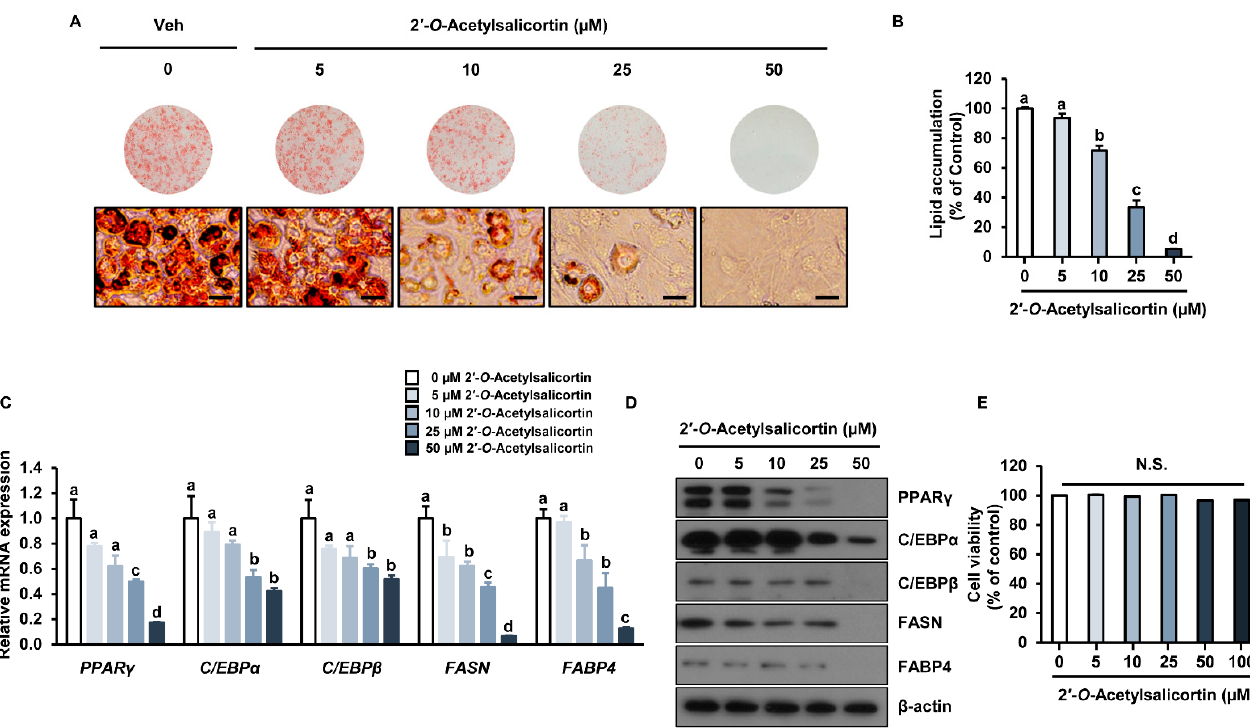
Figure 4. Inhibitory effect of 2 ′ - O -acetylsalicortin on adipogenesis. ( A ) 3T3-L1 cells treated with various concentrations of 2 ′ - O -acetylsalicortin during the adipocyte differentiation were stained with Oil Red O (upper) and analyzed by microscopy (bottom). ( B ) Quantification of intracellular lipid contents with spectrophotometry ( n = 3 per group). ( C ) Expressions of PPAR γ , FABP4 , FASN , C/EBP α , and C/EBP β genes were examined using qRT-PCR ( n = 3 per group). ( D ) Protein levels of C/EBP β , FASN, FABP4, C/EBP α , and PPAR γ were analyzed by immunoblotting. ( E ) Cytotoxic effect of 2 ′ - O -acetylsalicortin ( n = 3 per group). The values represent the mean ± SEM. The size of each scale bar in photomicrographs is 100 µ m. Mean values followed by different letters are significantly different ( p ≤ 0.05). N.S., not significant. Veh, vehicle treatment (negative